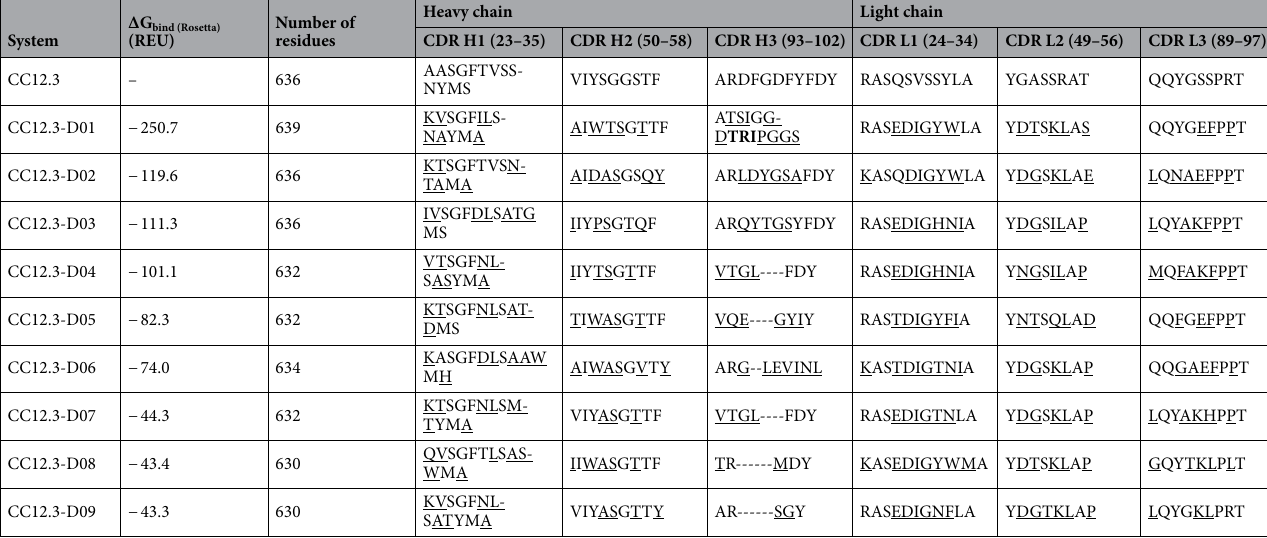
Table 1. Predicted binding free energies (ΔG bind (Rosetta) ) of designed Fabs CC12.3 to SARS-CoV-2-RBD and their CDR sequences. The mutated, inserted and deleted residues are underlined, highlighted in bold and represented with a hyphen,